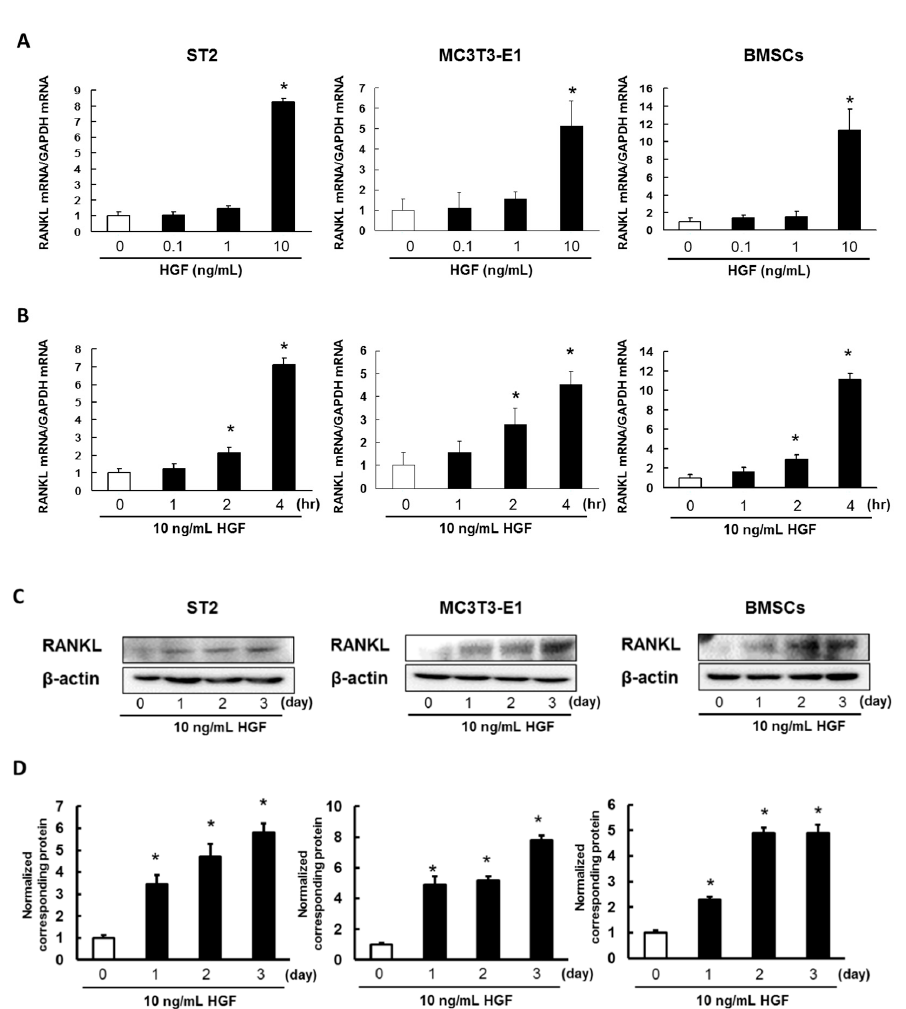
Figure 2. HGF enhances RANKL expression in BMSCs and osteoblasts. ( A ) ST2 cells, MC3T3-E1 cells, and mouse BMSCs were administrated with 0.1, 1, or 10 ng / mL HGF for 4 h. ( B ) ST2 cells, MC3T3-E1 cells, and mouse BMSCs were administrated with 10 ng / mL HGF for 1, 2, or 4 h. Total RNA was